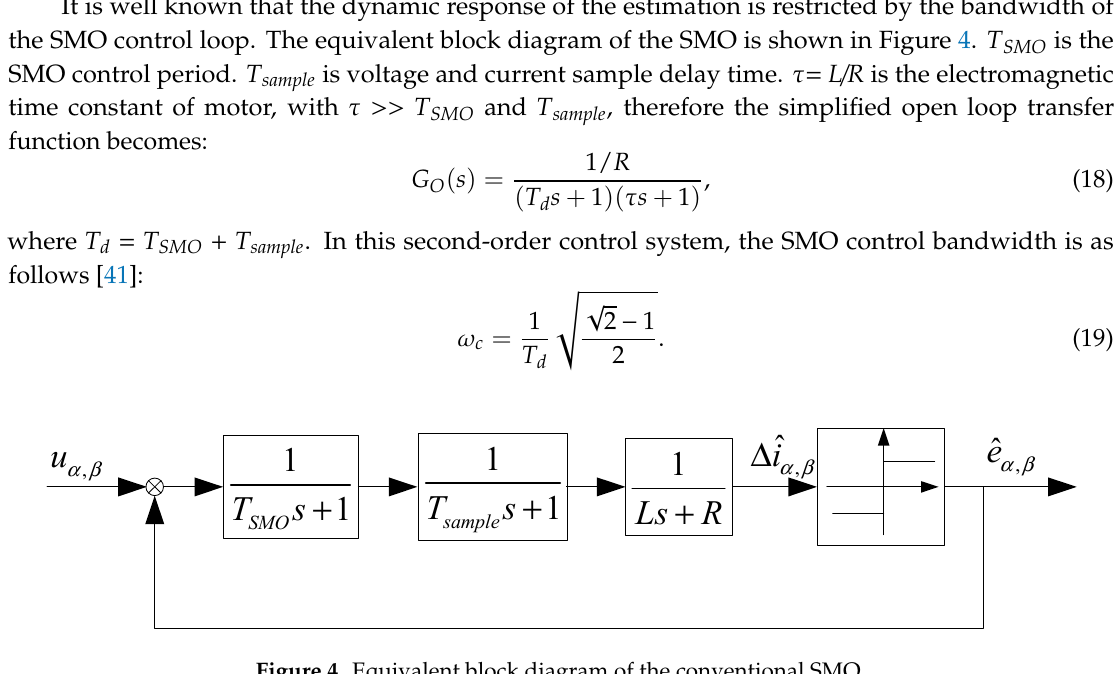
e θΔ Figure 3. Simulation results of the SMO with small DC-link capacitor.